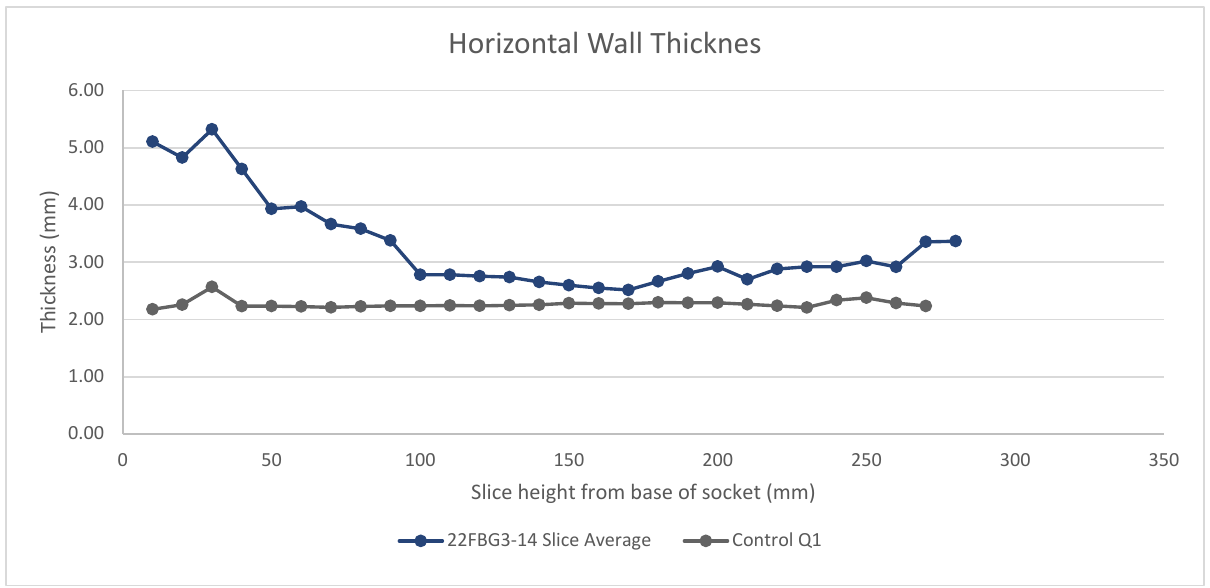
Figure 7. The horizontal wall thickness of the scanned model averaged across six radial cuts for each vertical slice compared to the control model showing a large disparity between the scan and control at the base of the socket.